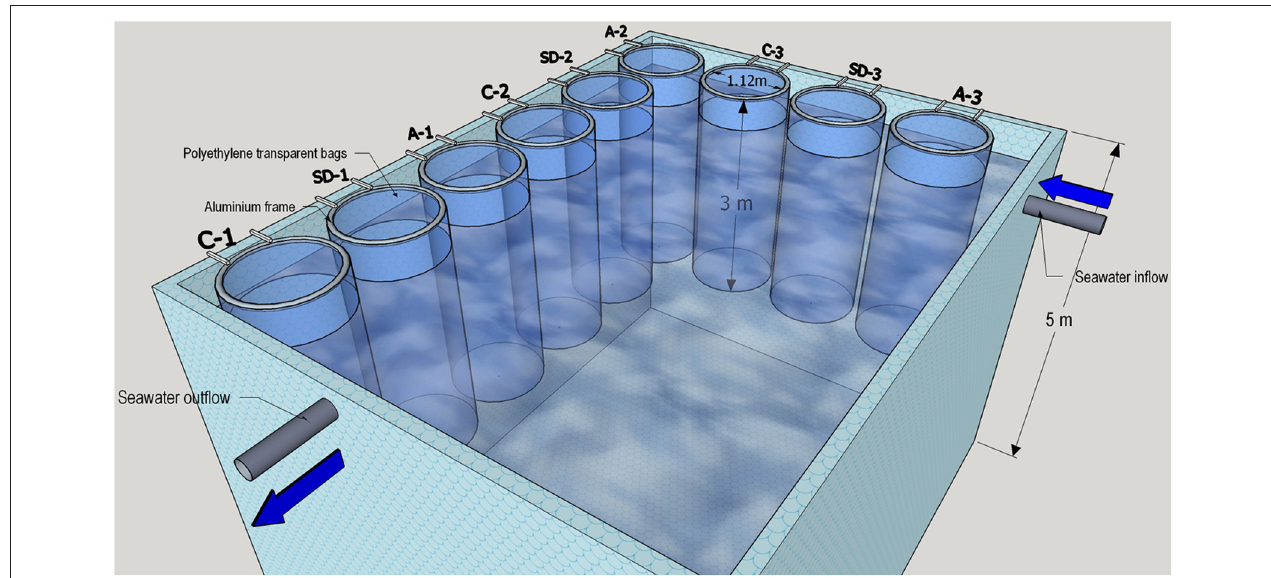
FIGURE 1 | A schematic illustration of the experimental mesocosm setup facility held in May 10-18 2012 in Crete. Two treatments (SD and A) and an unamended control (C) were run in triplicate 3m 3 mesocosm bags.